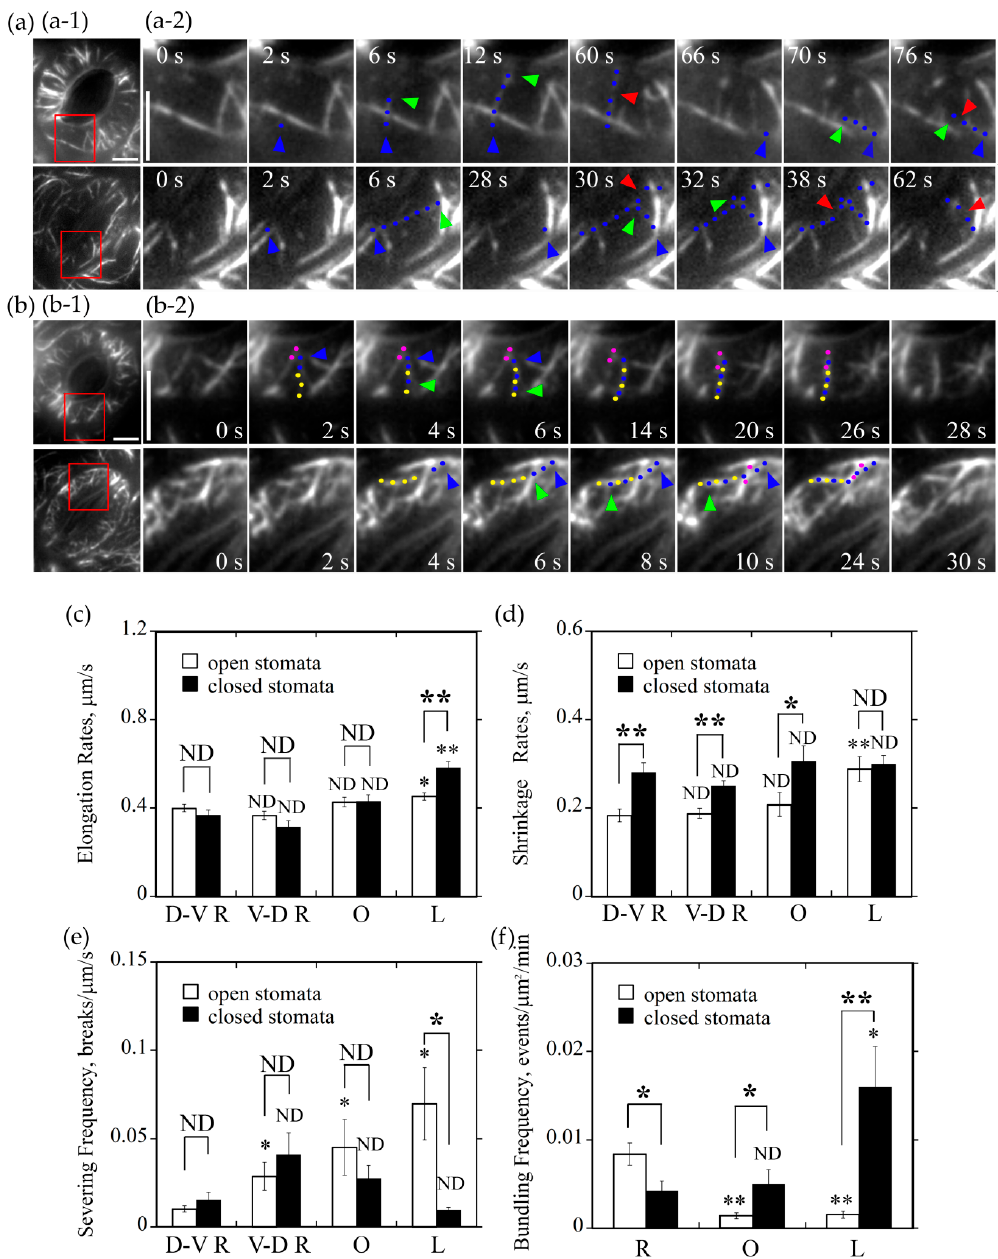
Figure 5. Radially oriented actin filaments tend to form bundles in guard cells of open stomata whereas longitudinally oriented actin filaments tend to form actin bundles in guard cells of closed stomata. ( a ) Longitudinally oriented actin filaments were prone to be severed in guard cells of open stomata but not in closed stomata. ( a - 1 ) Overviews of the organization of actin filaments decorated by GFP-ABD2-GFP in guard cells of open and closed stomata. The red box marked the region of interest. ( a - 2 ) Time-lapse series showed the severing activity of actin filaments in longitudinal orientation was higher than other oriented filaments in guard cells of open stomata but not in closed stomata. In open stomata, one actin filament that elongates from the starting point at 2 s to the ending point at 12 s, which indicated a dorsal-to-ventral radially oriented actin filament and it was severed at 60 s. Another actin filament elongates from the starting point at 66 s to the ending point at 70 s, which indicated the longitudinally oriented actin filament and it was severed at 76 s. However, in closed stomata, one